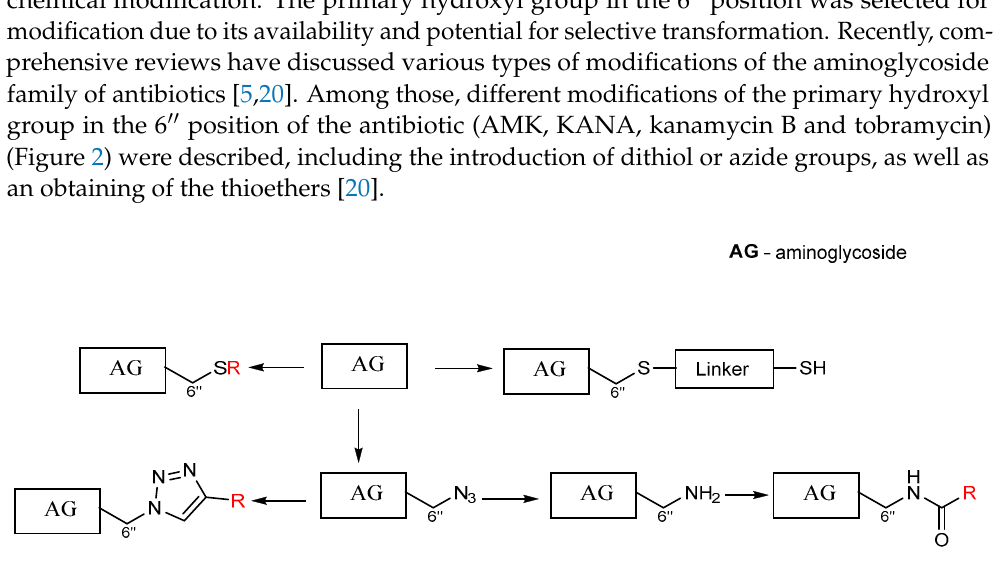
Figure 2. Types of semisynthetic AG derivatives obtained by the chemical transformation of the 6 ″ -hydroxy group.